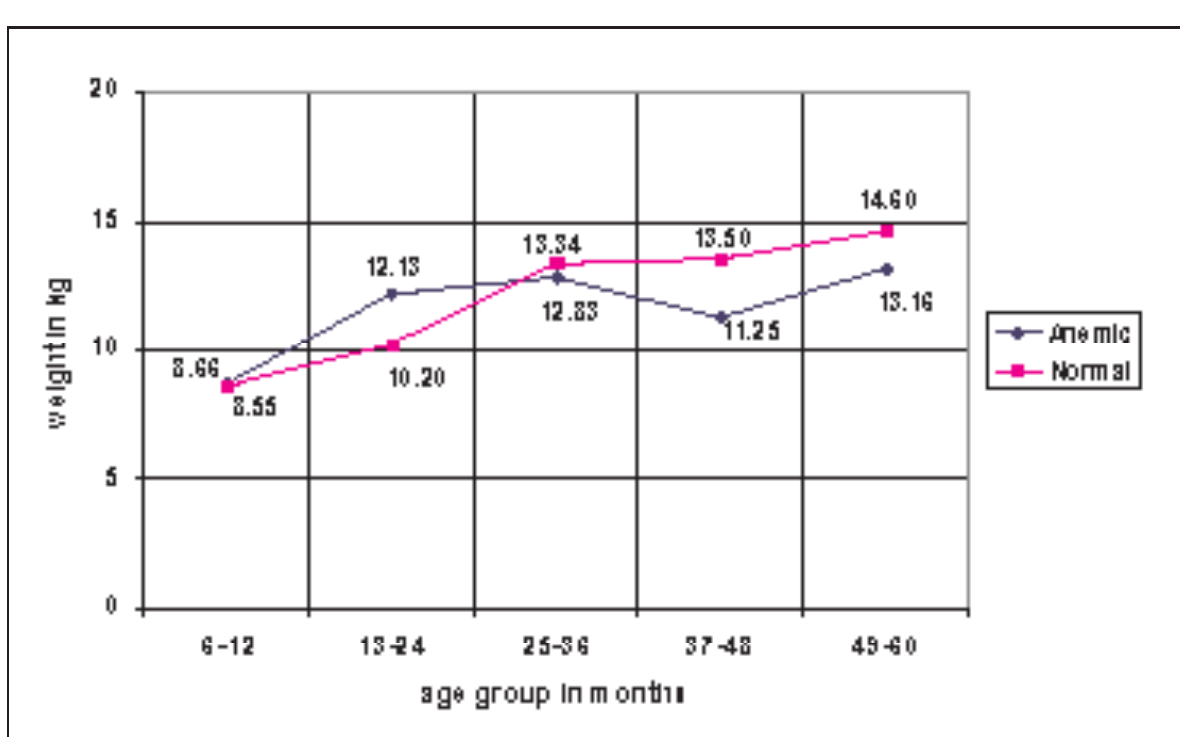
Fig. 5: Average Wt. of anemic vs normal children (Males) Among the total anemic patient 72% male and 28% fe- male .Among those with severe anemia all were male and among those with moderate anemia 10.34% were male and only 0.94 % was female and among the mild anaemia 15 % were male and 10.3% were female. This showed that among the anemic children of under five age group